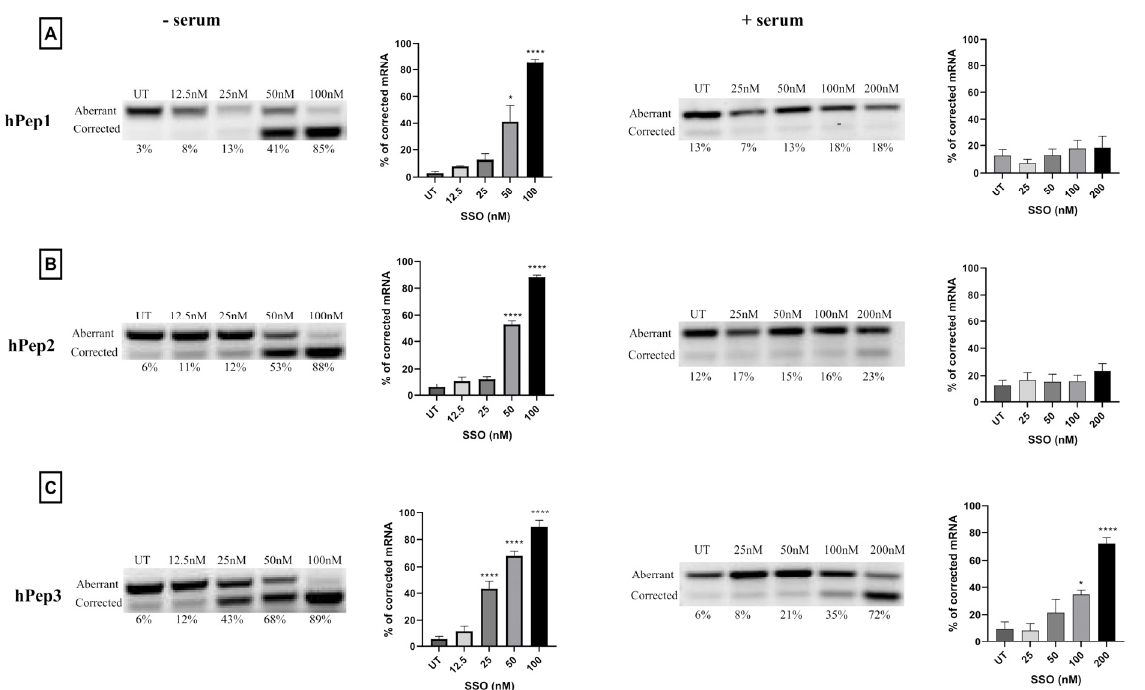
Figure 4. Splice-switching activity evaluation on luciferase mRNA level in HeLa 705 reporter cell line. Cells were transfected with increasing concentrations of hPep/SSO formulations. Cells were incubated with hPep/SSO nanoparticles for 24 h in both serum-free media (panels on the left) and serum-containing media (panels on the right) with ( A ) representing hPep1, ( B ) hPep2 and ( C ) hPep3. Splice-switching activity on the mRNA level was analyzed with RT-PCR. Products were separated by gel electrophoresis and correction values were derived from densitometric analysis. Representative gel for every condition is displayed (upper band = uncorrected mRNA, lower band = corrected mRNA). Bar graphs represent the mean % of mRNA correction derived from at least three independent experiments (mean ± SEM). p -values were determined by one-way ANOVA using Dunnett ′ s multiple comparison test (* p < 0.05, **** p < 0.0001).